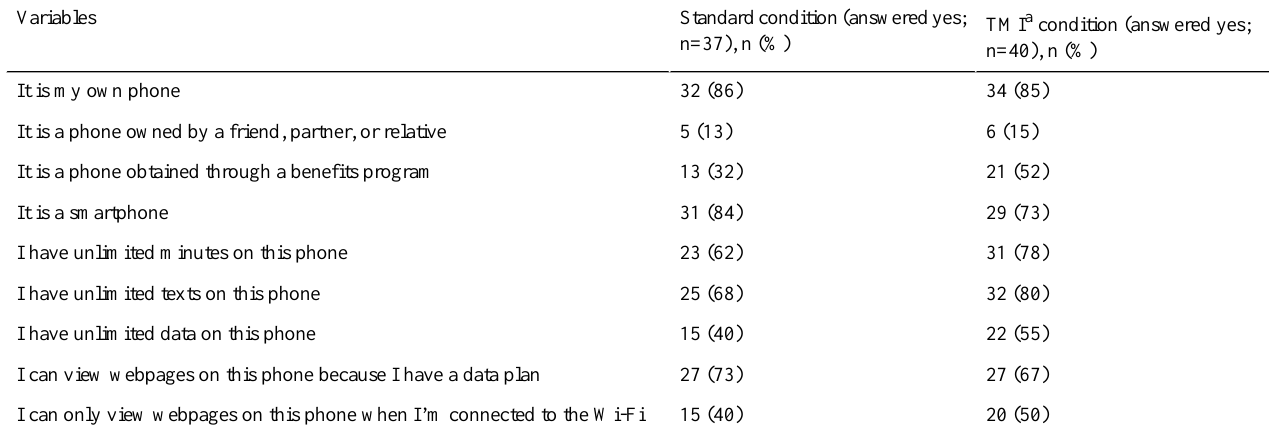
Table 1. Participant cellphone characteristics at baseline.